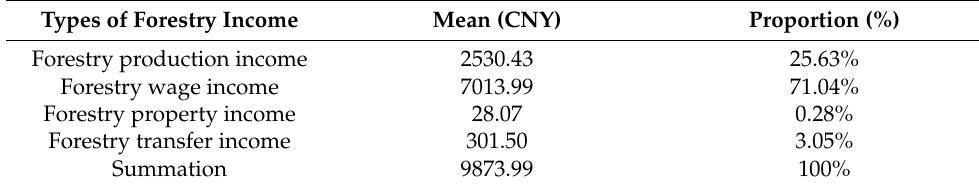
Table 6. The overall situation of all types of forestry income of the sample rural households. Types of Forestry Income Mean (CNY) Proportion (%) Forestry production income 2530.43 25.63% Forestry wage income 7013.99 71.04% Forestry property income 28.07 0.28% Forestry transfer income 301.50 3.05% Summation 9873.99